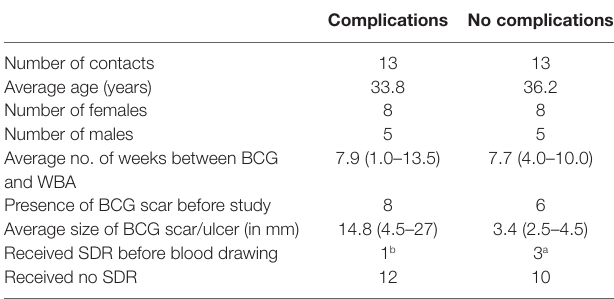
TaBlE 2 | Characteristics of contacts with BCG-related complications and matched